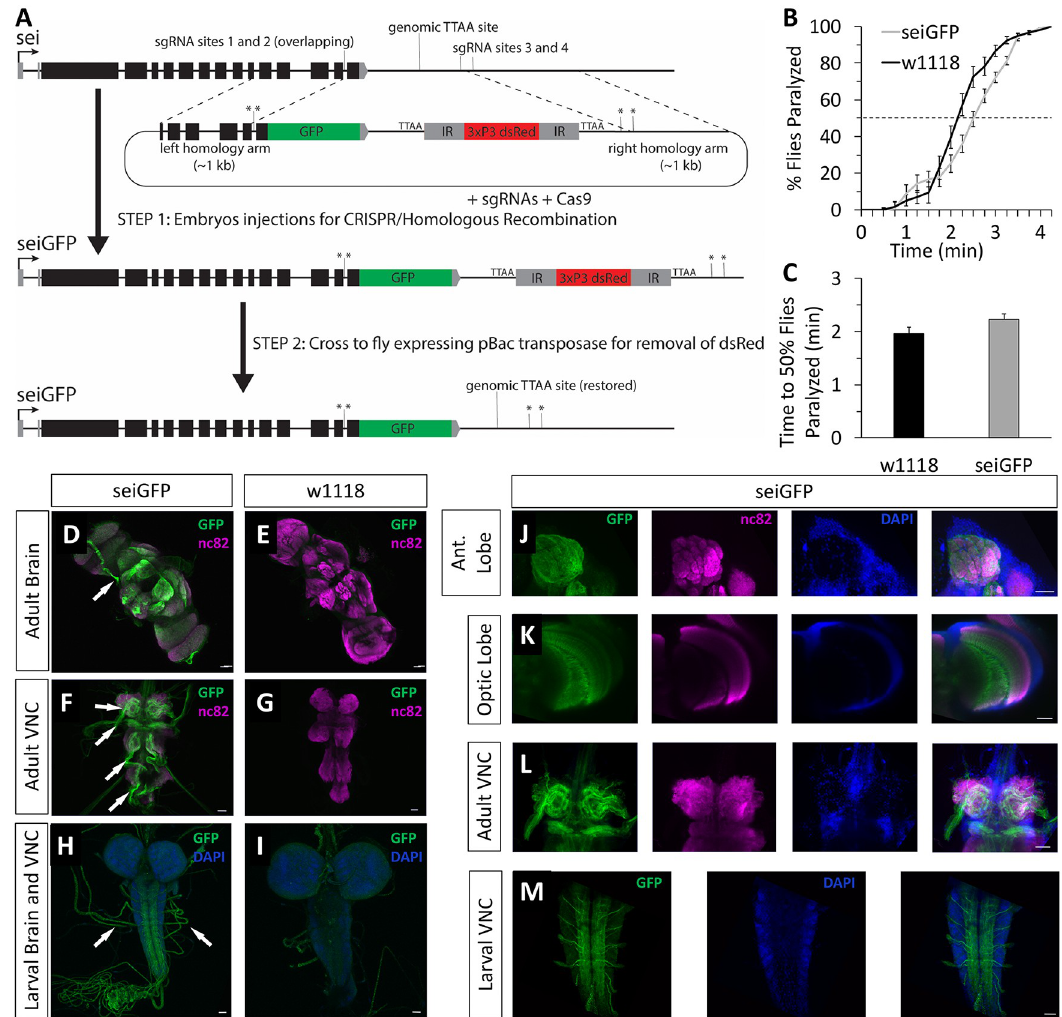
Fig 8. Nervous system expression of seiGFP in adults and larvae is primarily localized to neuronal axons. A ) Strategy for the generation of the seiGFP allele by using CRISPR/ Cas9 -dependent DNA editing. Stars represent single nucleotide substitutions in the PAMs of sgRNA sites. B-C ) Behavior of seiGFP and wildtype flies in the acute heat assay. n = 12. Data was analyzed using Student’s t - test and presented as mean ± SEM. D-G ) Representative 20x confocal z-stack images of the adult brain ( D-E ) and adult ventral nerve cord ( F-G ) following immunostaining for seiGFP (green) and nc82 (magenta). H-I ) 20x confocal z-stack images of the larval brain and ventral nerve cord of seiGFP (green) and DAPI (blue). Note that low levels of green autofluorescence are observed in the w 1118 larval brain. J-M ) 40x confocal z-stack images of the adult antennal lobe ( J ), optic lobe ( K ) and ventral nerve cord ( L ) with seiGFP (green), nc82 (magenta) and DAPI (blue). M ) 40x confocal z-stack images of the larval ventral nerve cord of seiGFP (green) and DAPI (blue). Scalebars are 20 μ m. White arrows point to neuronal tracks with enriched seiGFP localization.